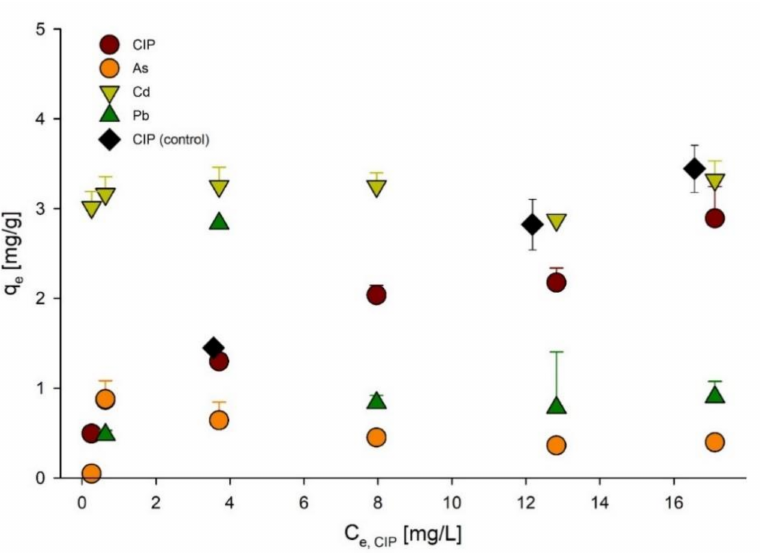
Figure 7. Co-adsorption of ciprofloxacin (CIP) and heavy metals; CIP concentration 0.5–20 mg/L, heavy metals 4